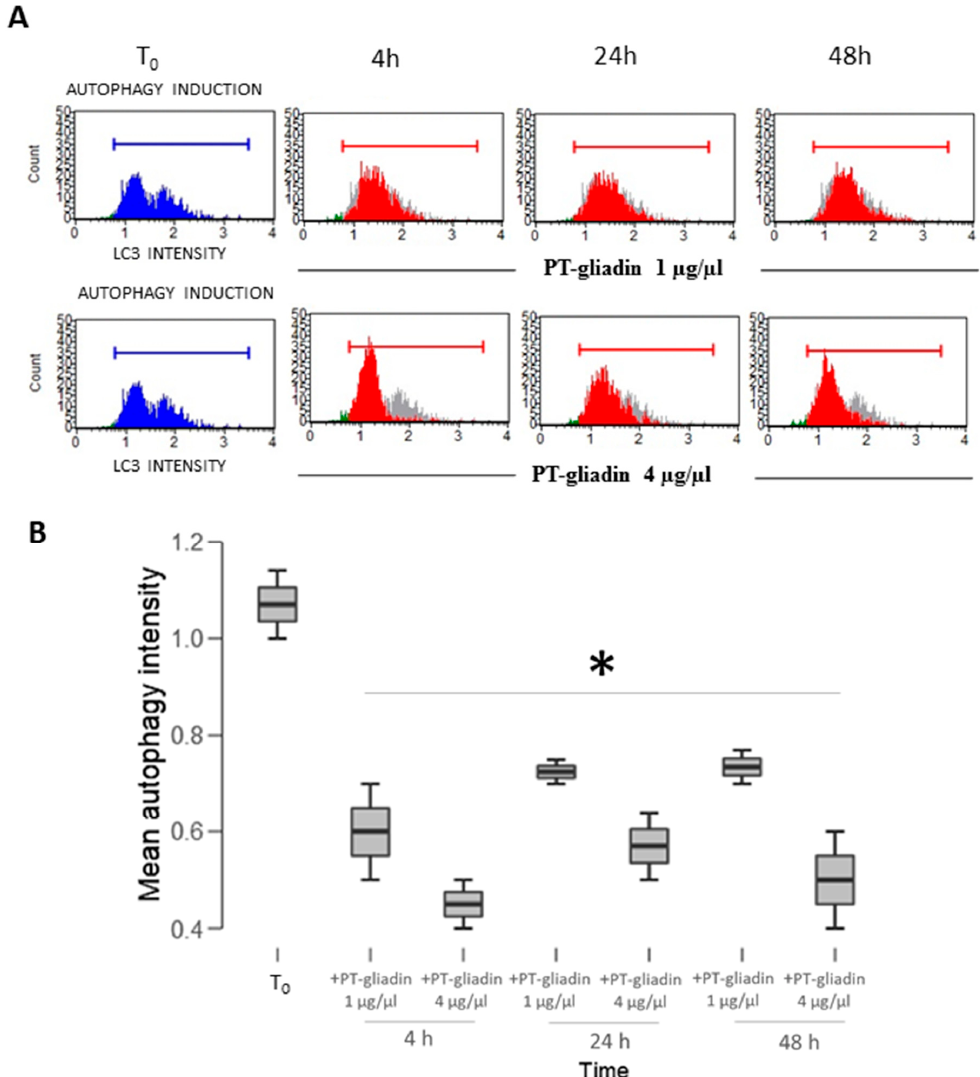
Figure 8. LC3-II expression in Caco-2 cells after PT-gliadin administration. ( A ) Cytofluorimetric plots representing LC3-II expression in Caco-2 cells incubated with 1 or 4 µg/µL of PT-gliadin at different time intervals (h); ( B ) Graphical summary of LC3-II expression trends. Asterisks indicate p < 0.05, Anova One-way, as compared to untreated NT samples at T 0 . Int. J. Mol. Sci. 2017 , 18 , x FOR PEER REVIEW